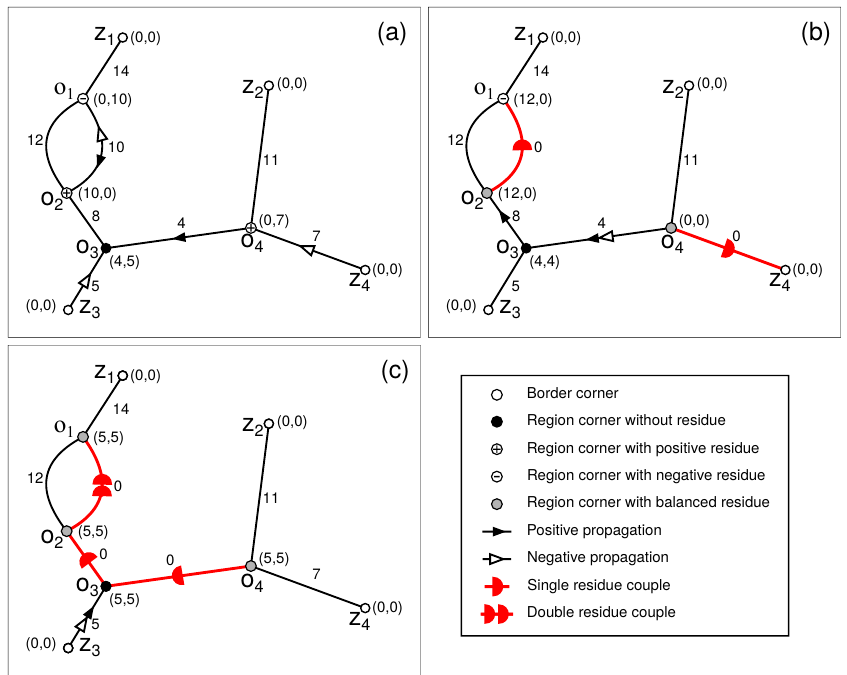
Figure 4. A graph ( a ) derived from Figure 2 and its continuity distance map after the first coupling ( b ) and the second coupling ( c ). Distance values noted in the pair as ( R + , R − ) near the vertices and Λ values noted beside the edges. Solid and open arrows indicate the positive and negative propagation,